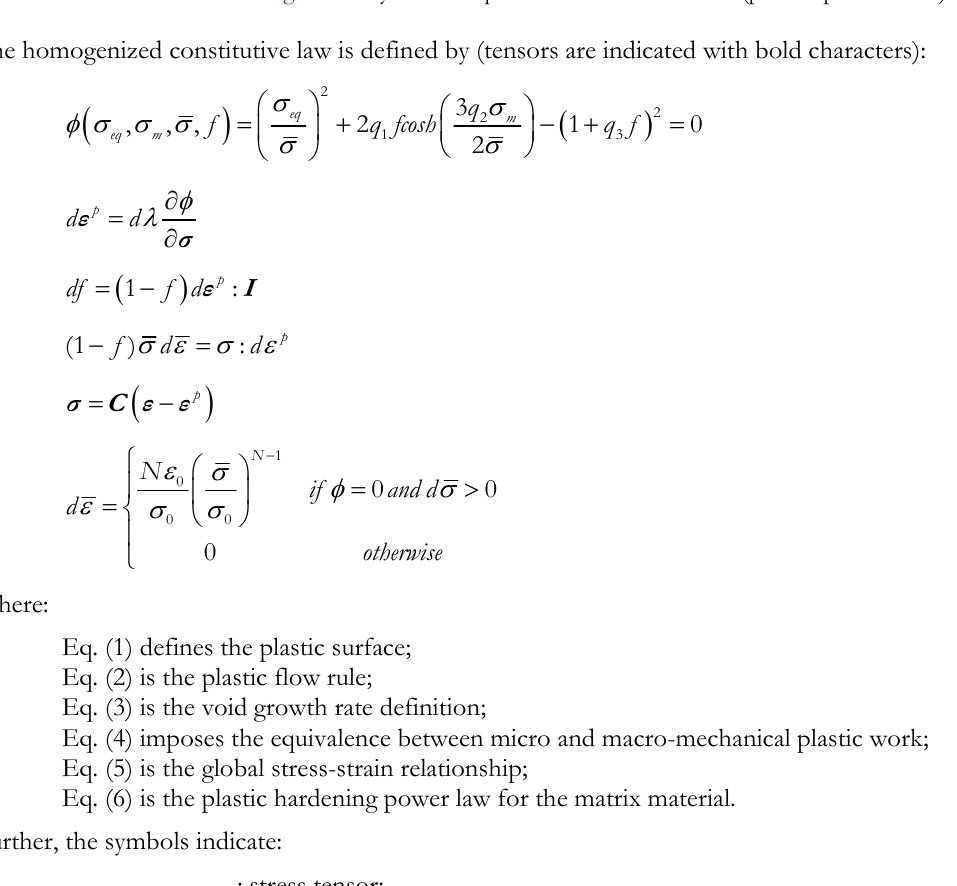
Figure 1: Physical vs. equivalent voids distribution (plane